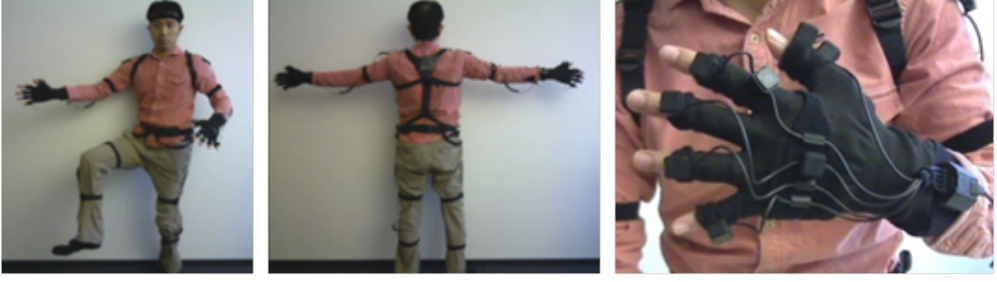
Figure 1. Sensor displacement in Perception